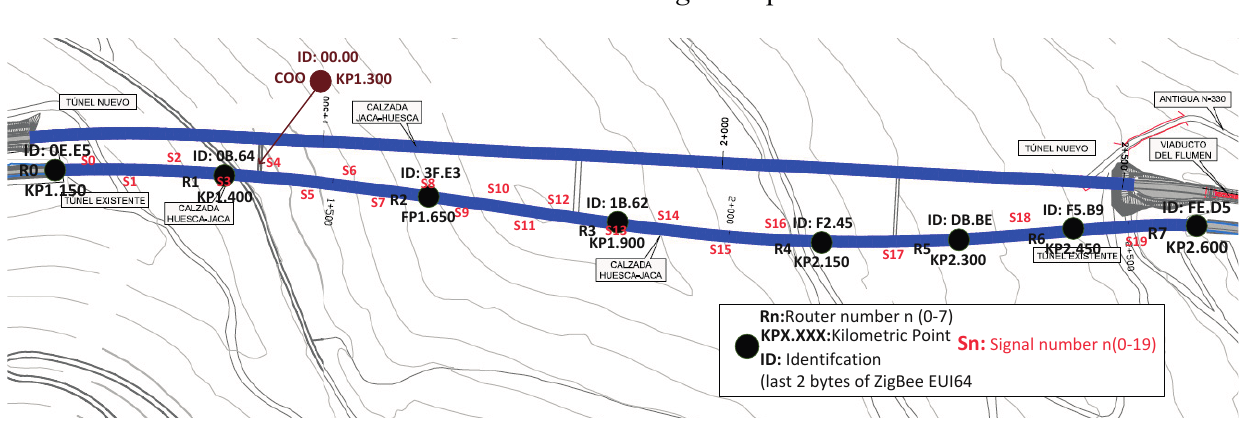
Figure 11. Distribution of routers and Smart Signals in Monrepos I